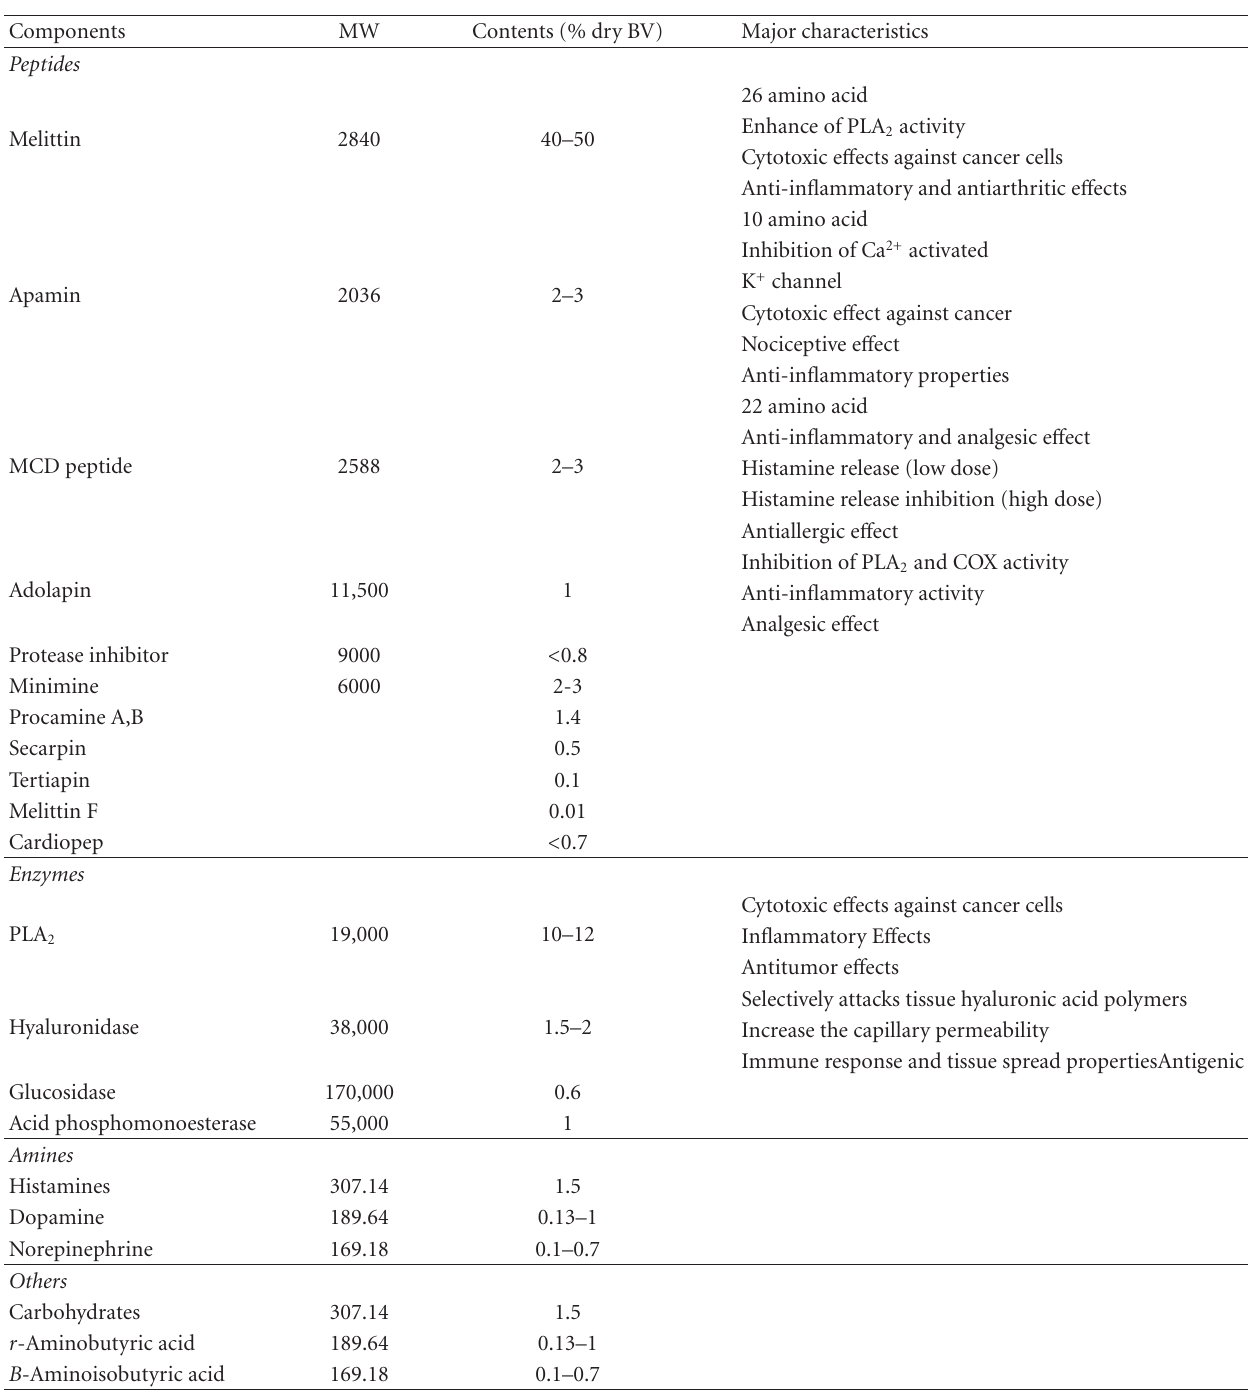
Table 4: Components of bee venom and their major